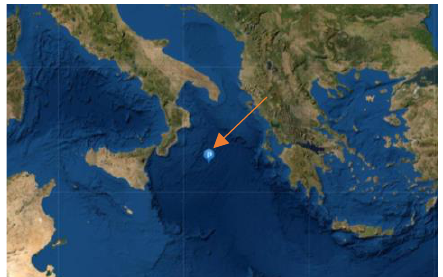
Figure 3. Offshore dataset reference point (37.60°,18.00°). The arrow indicates the considered loca- tion.